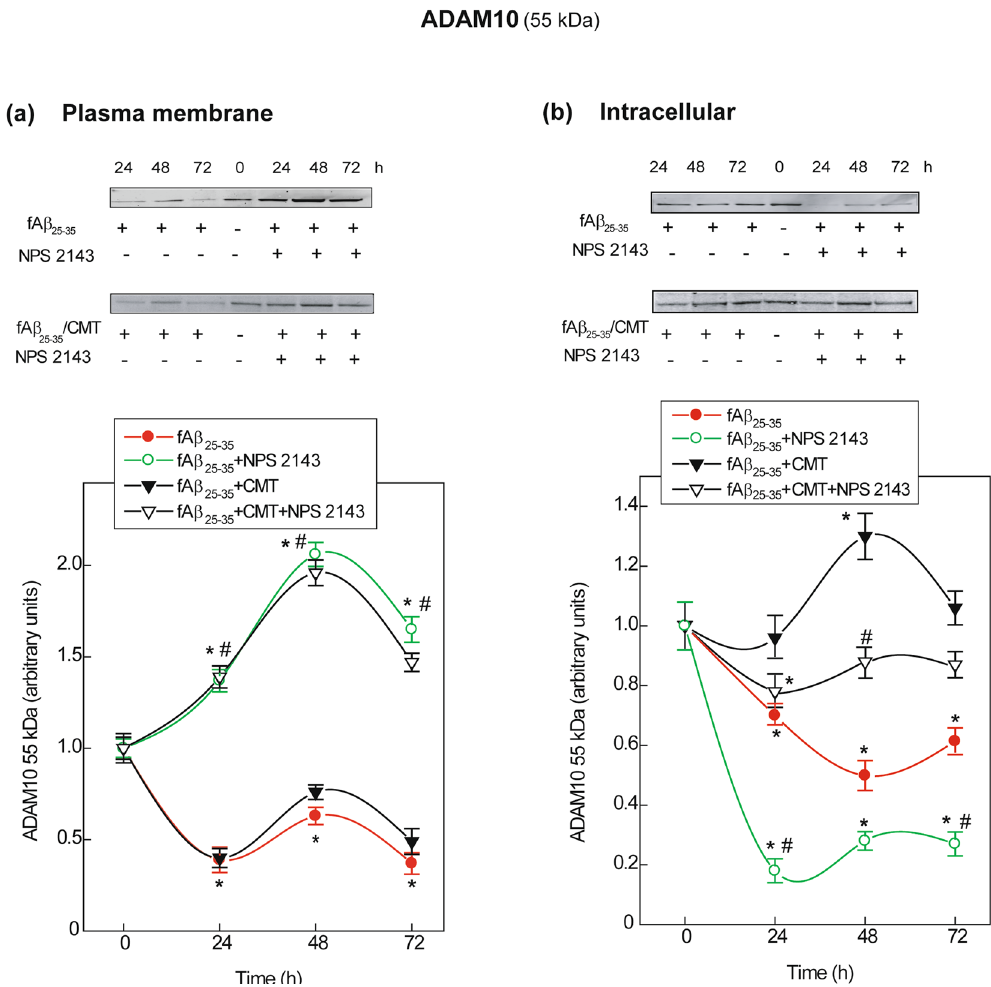
Figure 4. Changes in ADAM10 protein expression and subcellular distribution in human astrocytes. (a ) Top . Typical immunoblots revealing changes in cell surface biotinylated ADAM10 levels (details in Methods ) according to experimental treatments versus untreated controls. Blots have been cropped to size for clarity. Bottom . Densitometric evaluations of specific ADAM10 bands for each treatment and time point. Points in the curves are means ± SEM of 3 independent experiments, with 0-h (controls) values normalized as 1.0. One-way ANOVA analysis of ( i ) fA β 25–35 ± NPS2143 data set: F = 73.625, P < 0.001; ( ii ) fA β 25–35 + CMT ± NPS2143 data set: F = 55.591, P < 0.001; Bonferroni t-test : comparisons of each treated group versus 0-h group (controls): * P < 0.05; pair-wise comparisons between corresponding treatments ± NPS 2143 at each time point: # P < 0.05. (b ) Top . Characteristic immunoblots exposing changes in the levels of non-biotinylated intracellular ADAM10 according to the specific treatments versus untreated controls. In all cases blots have been cropped to size for clarity. Bottom . Densitometric evaluation of specific ADAM10 bands for each treatment and time point. Points in the curves are means ± SEM of 3 independent experiments, with 0-h values normalized as 1.0. One-way ANOVA analysis of ( i ) fA β 25–35 ± NPS2143 data set: F = 34.818, P < 0.001; ( ii ) fA β 25–35 + CMT ± NPS2143 data set: F = 10.938, P < 0.001; Bonferroni t-test: comparisons of each treated group versus 0-h (controls): * P < 0.05; pair-wise comparisons between corresponding treatments ± NPS 2143 at each time point: # P <